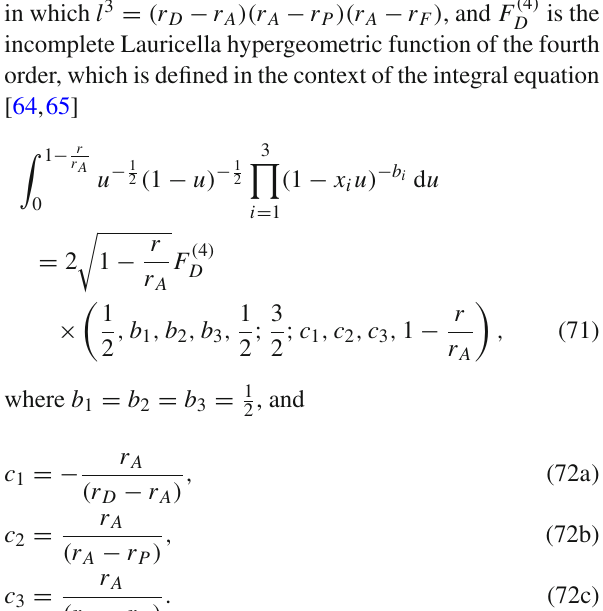
Fig. 11 Some examples of time-like planetary orbits, plotted in accor- dance with the effective potential in Fig. 10, for the energies a E 2 = 0 . 709, b E 2 = 0 . 710, c E 2 = 0 . 712, d E 2 = 0 . 714, e E 2 = 0 . 716,